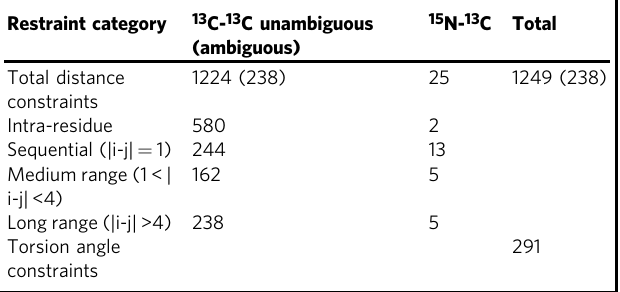
Table 1 Summary of MAS NMR distance constraints for CFL2 bound to ADP-F-actin.